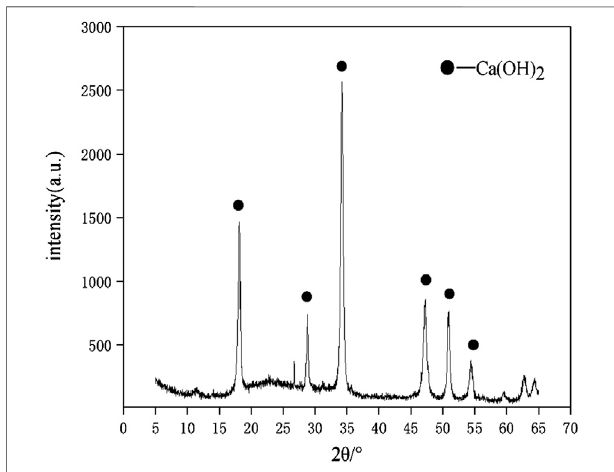
FIGURE2 | XRD diffractogram of carbide slag.